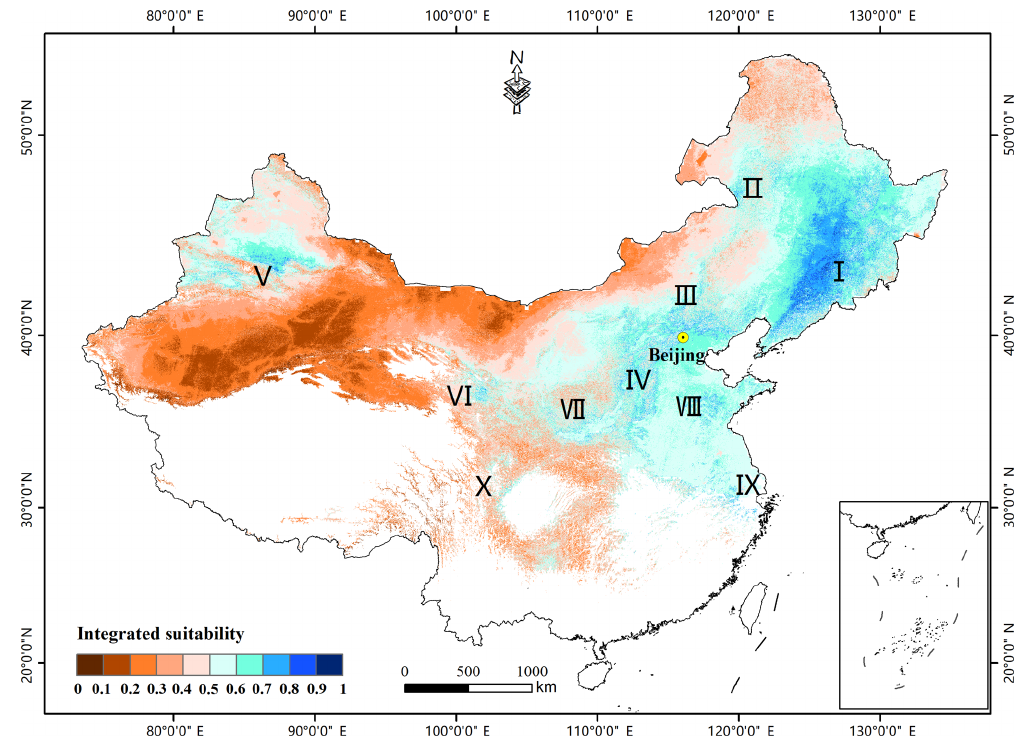
Figure 5. The spatial distribution of integrated suitability for ski area development based on the natural and socioeconomic indexes.